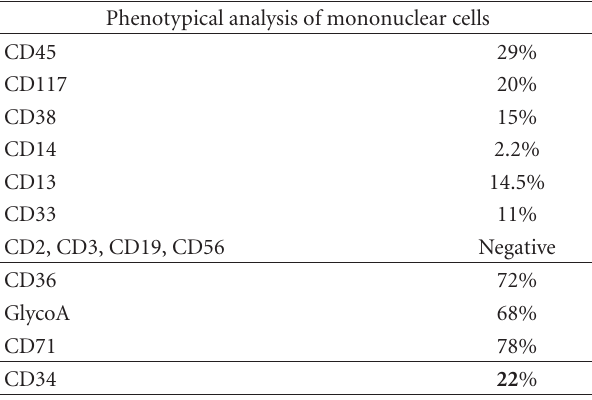
Table 1: Flow cytometric analysis of fetal liver cells before CD34 + immunomagnetic separation. Fetal liver was dissociated, and the mononuclear cells were isolated by density-gradient centrifugation and analyzed by flow cytometry for di ff erent cell surface markers. Results are presented as the percentage of positive cells. CD: cluster of di ff